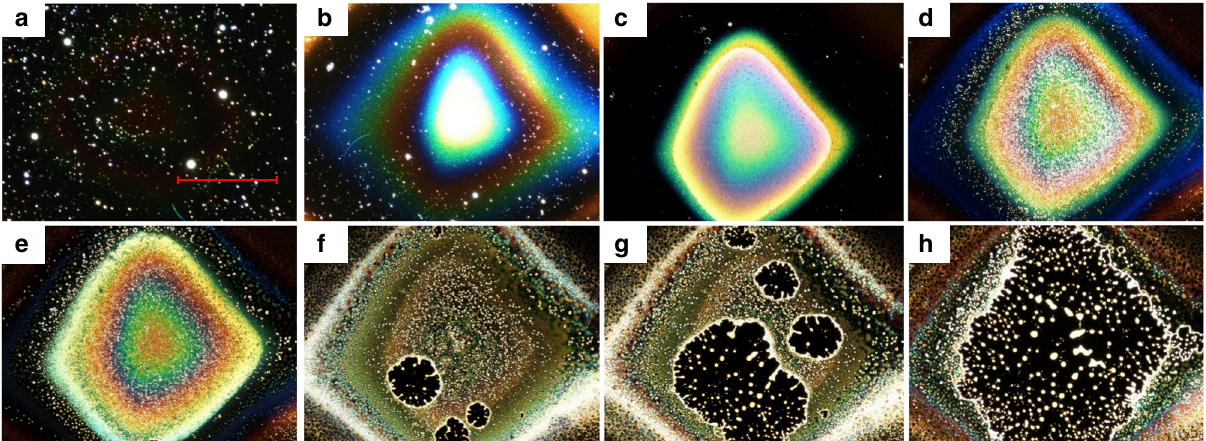
Fig. 4 Change in the optical properties of the [B 12 I 12 ] 2 − -based layer during water induced dewetting. Dark fi eld optical microscopy images (scale bar = 600 2 − layer on FSAM induced by continuous intake of water. a before the experiment a smooth layer is not visible in µ m) showing the change in the [B 12 I 12 ] dark fi eld, b – e continuous change of the surface morphology during water intake, f – h layer ruptures and holes grow. Droplets are formed on the surface